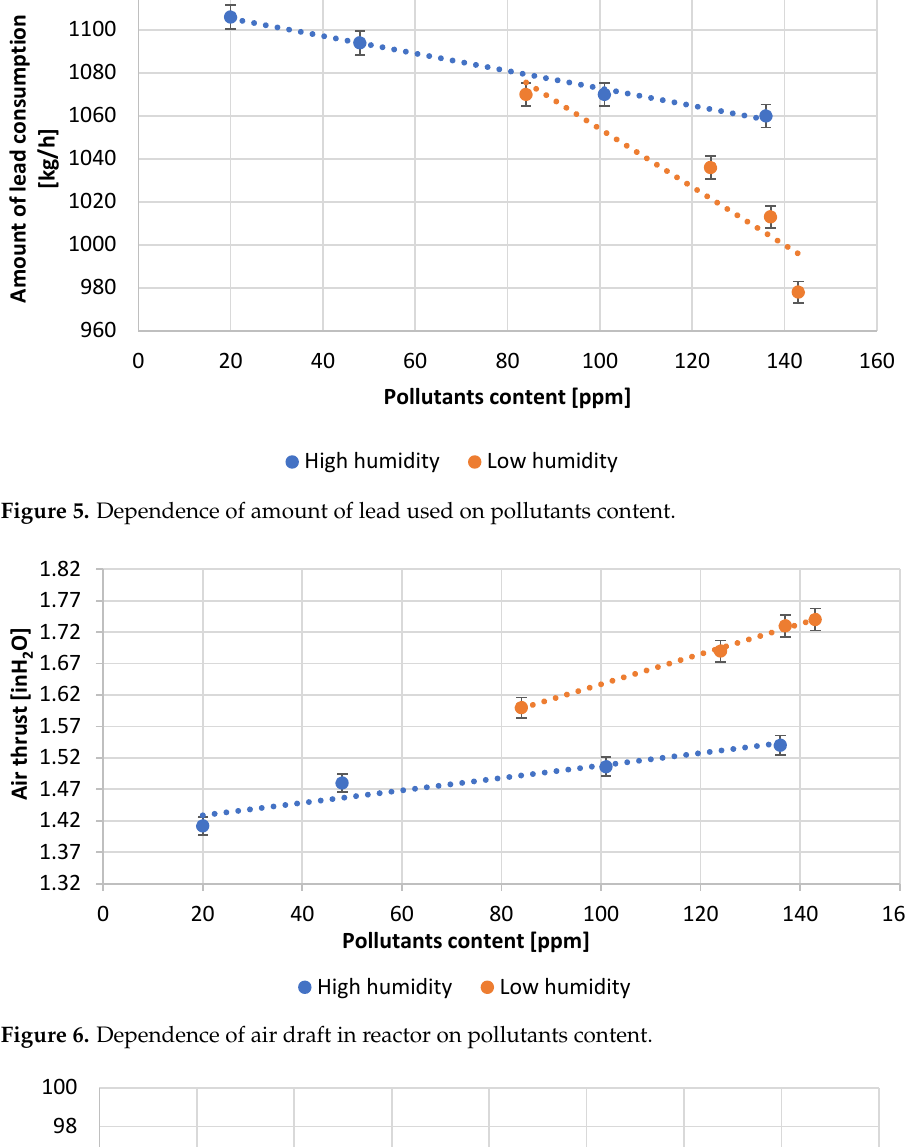
Figure 4. Dependence of amount of water used for production on pollutants content.